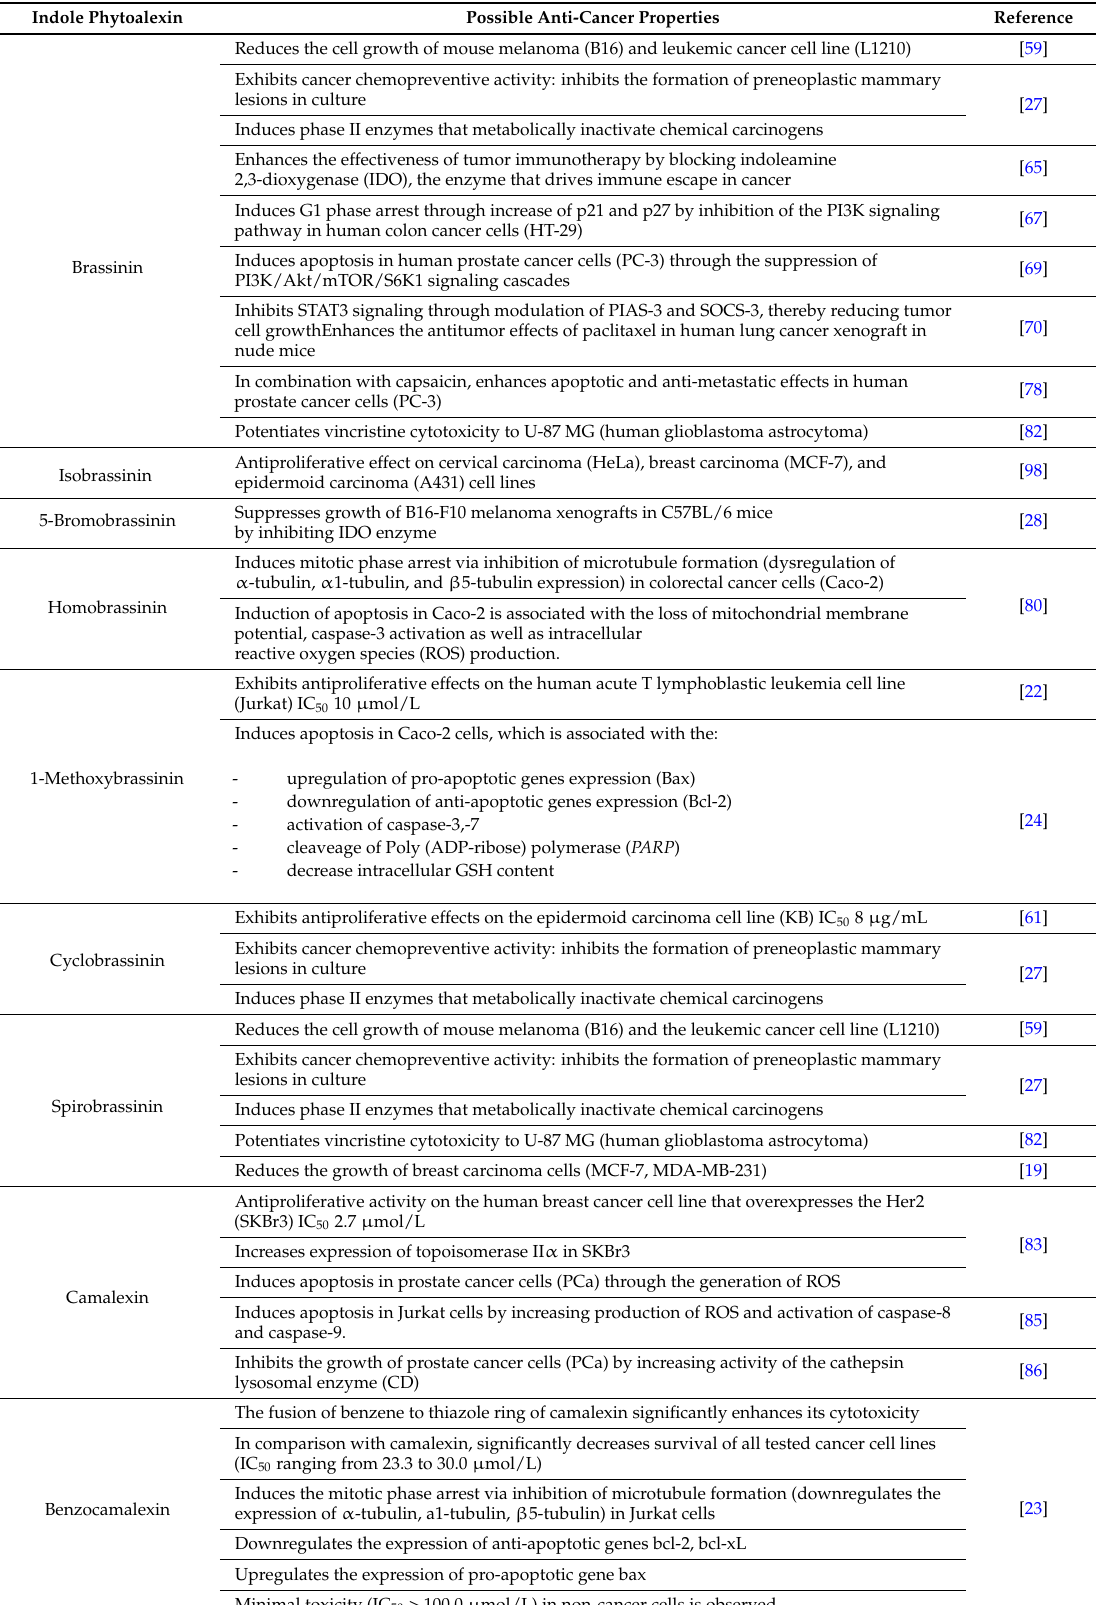
Table 1. Summarizing possible anti-cancer properties of representative indole phytoalexins and their